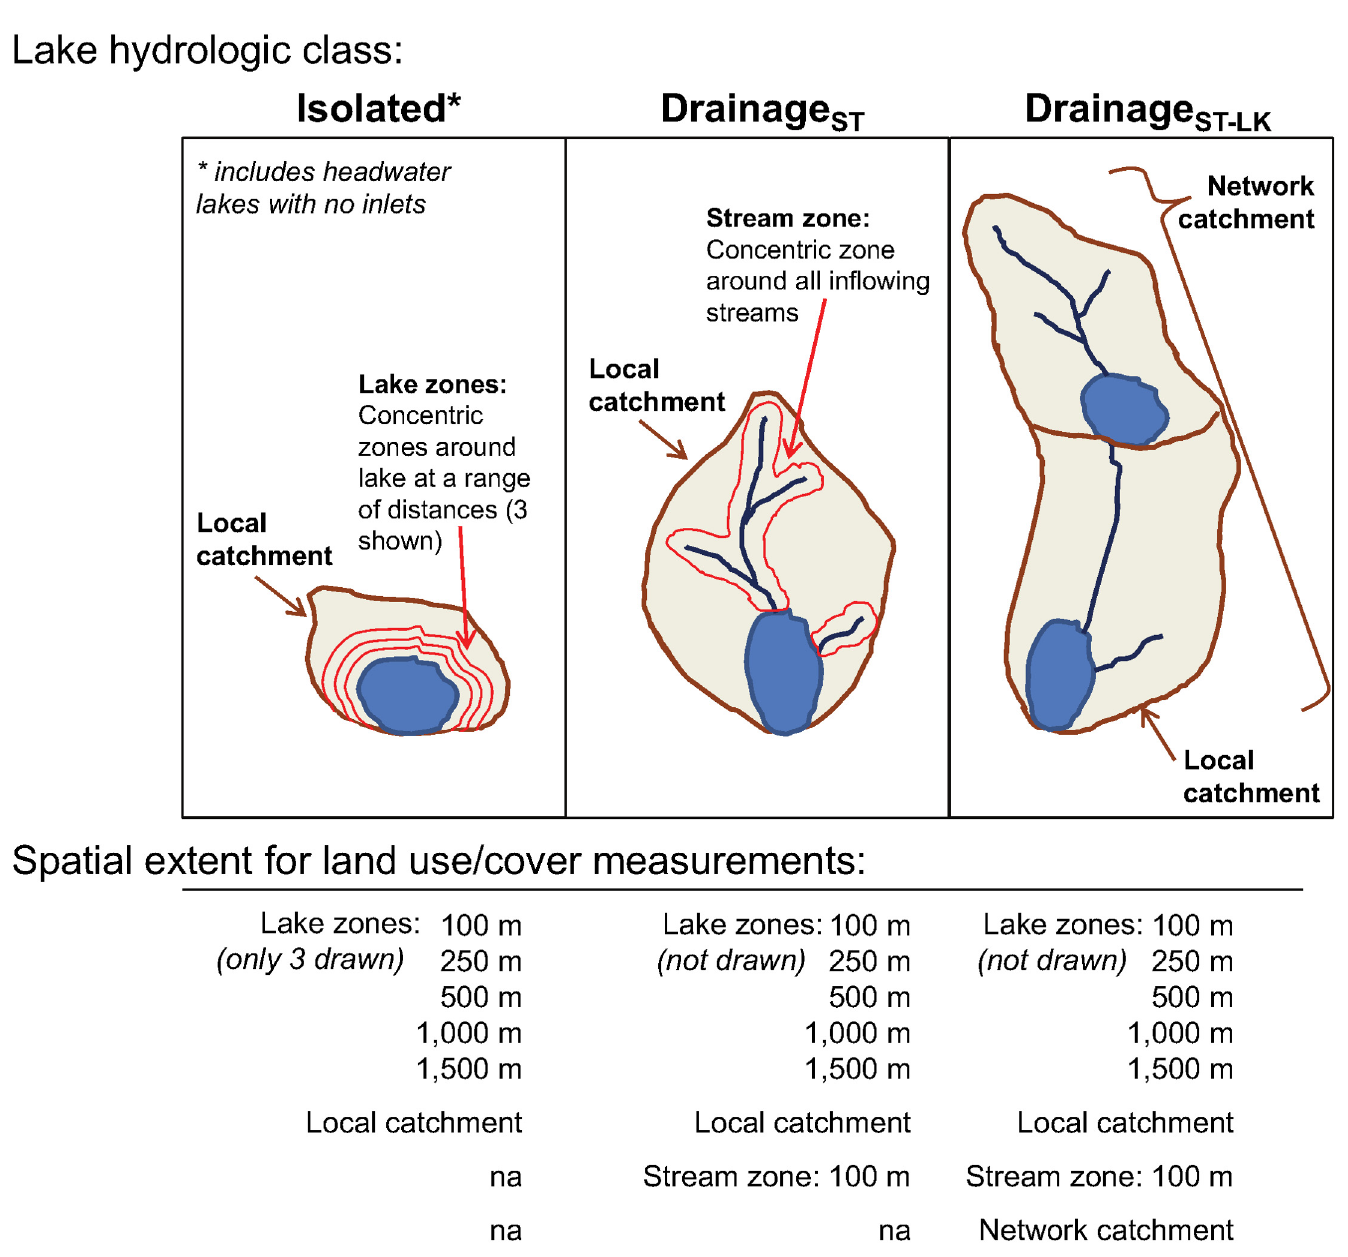
Fig 2. A description of lake hydrologic classes and the spatial extents for land use measurements. A diagram explaining the features of the 3 different lakes classes and the spatial extents tested in this study. The lake zones are shown on the isolated lake diagram, the stream zone is shown in the DR ST diagram, and the network catchment is shown in the DR ST-LK diagram. However, such scales are also quantified for some (but not all) of the different lake classes as depicted in the bottom half of the diagram. na is not